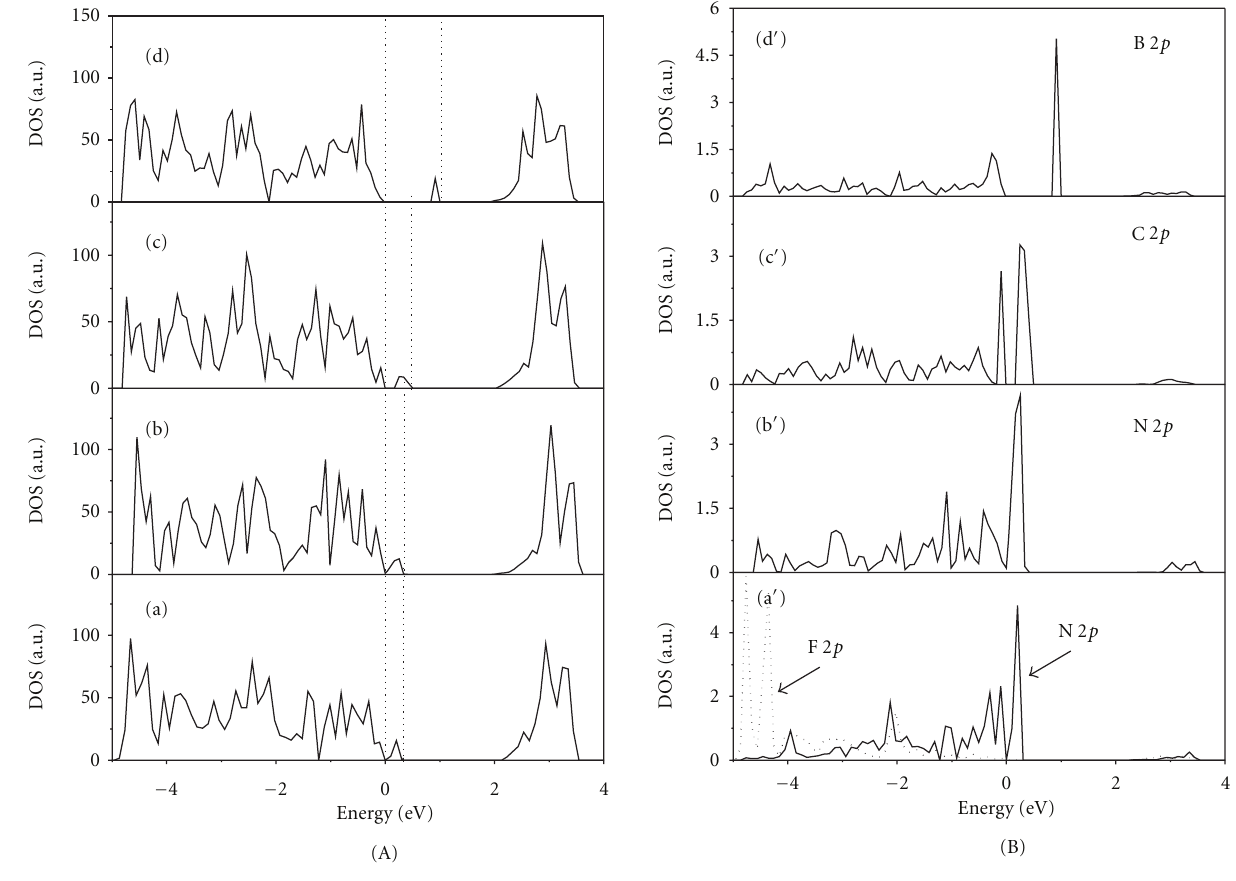
Figure 4: Total densities of states (A) and projected densities of states (B) for (a) N:F codoped TiO 2 , (b) N:H-doped TiO 2 , (c) C:2H-doped TiO 2 , (d) B: 3H-doped TiO 2 . The vertical dash line defines the highest occupied